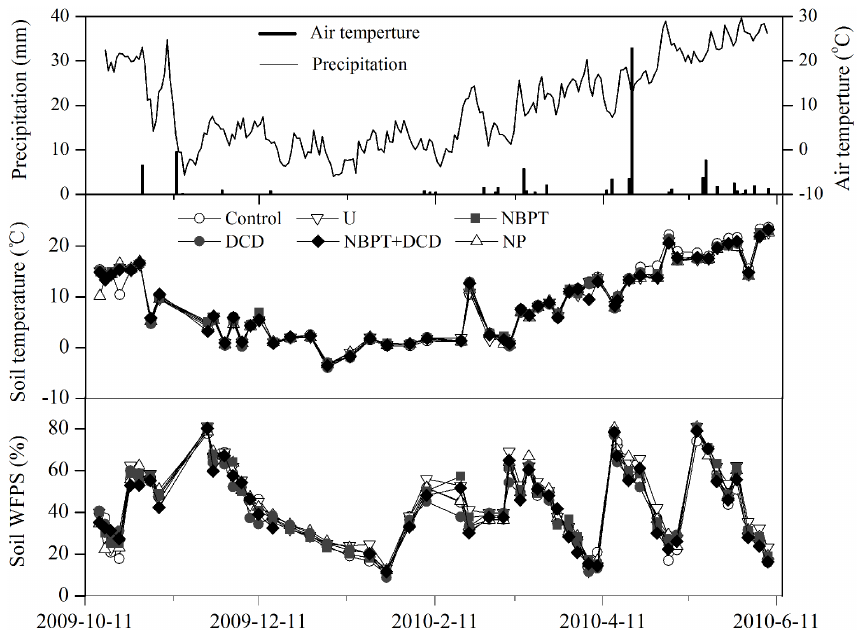
Figure 1. Temporal variation of daily precipitation and air temperature, and mean soil moisture and water-filled pore space (WFPS) at time of N 2 O sampling in the control, urea alone (U), urea with NBPT (NBPT), urea with DCD (DCD), urea with NBPT plus DCD (NBPT plus DCD) and nitrophosphate (NP) treatments during the wheat growth season. The standard errors of soil temperature and moisture were not shown for figure clarity. Table 2. Effects of urease and/or nitrification inhibitors and nitrophosphate on wheat biomass, amount of N uptake by crops and N use